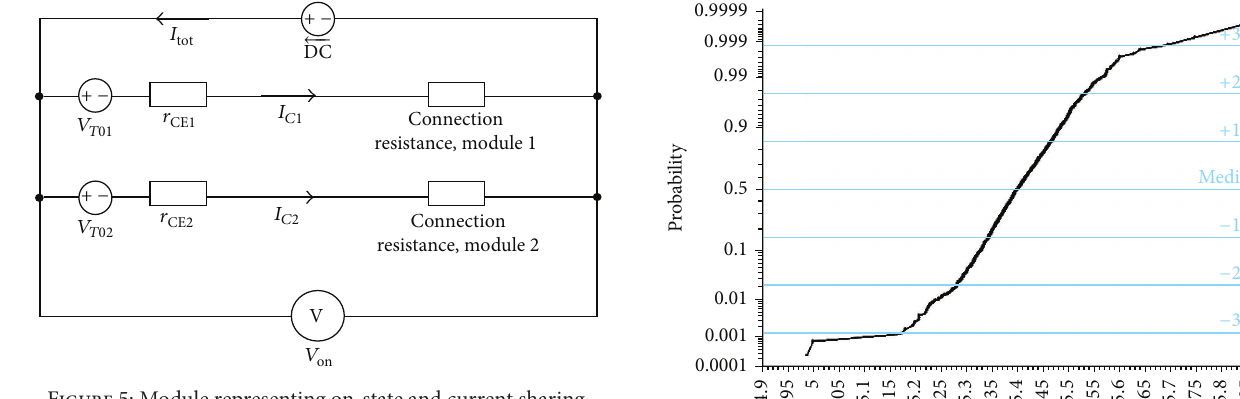
Figure 5: Module representing on-state and current sharing.